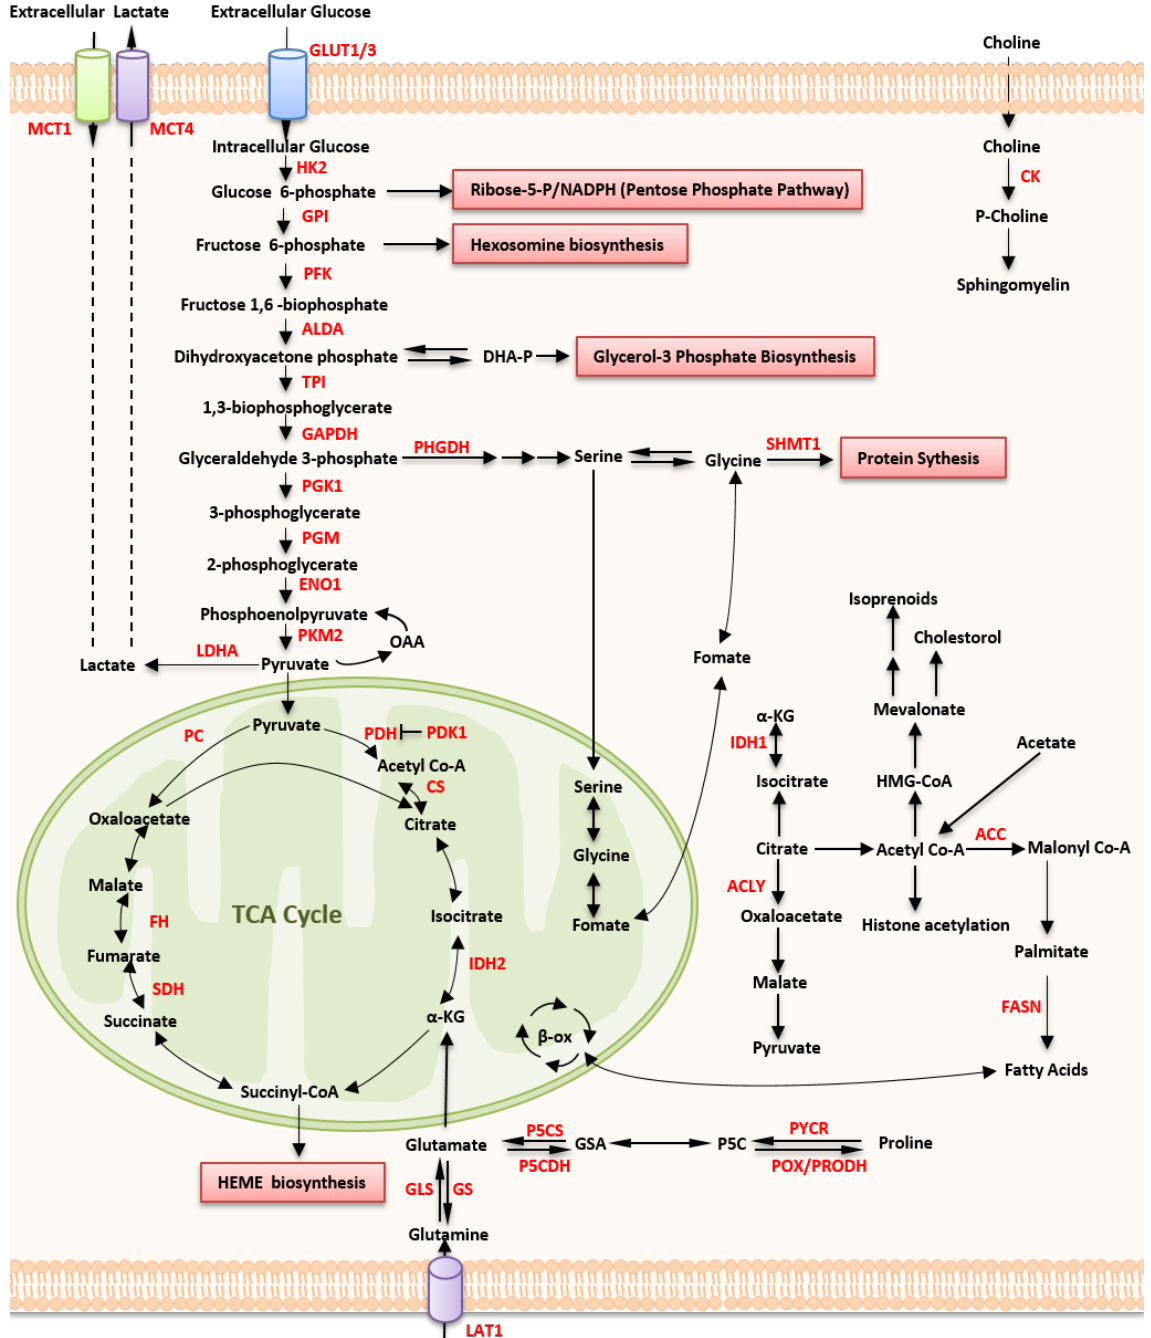
Figure 1. Metabolic pathways in lymphoma. Lymphoma cells take up glucose and glutamine also to fuel the tricarboxylic acid (TCA) cycle, oxidative phosphorylation (OXPHOS), the pentose phosphate pathway (nucleotide synthesis), and the syntheses of hexosamine (involved in the synthesis of glycosylated molecules), amino acids (proteins), and lipids. Lymphoma cells are also able to take up lactate, free fatty acids, and ketones released predominantly by surrounding catabolic cells, which can be used to replenish TCA-cycle intermediates and fuel OXPHOS. Together, these pathways generate sufficient levels of cellular components to support cell proliferation (necessary nutrient transporters and metabolic enzymes are highlighted in red). Abbreviations: MCT1, monocarboxylate transporter 1; MCT4, monocarboxylate transporter 4; GLUT1/GLUT4, glucose transporter 1/4; HK2, hexokinase; GPI, glucose-6-phosphate isomerase; PFK, phosphofructokinase; ALDA, al- dolase A; TPI, triosephosphate isomerase; GAPDH, glyceraldehyde-3-phosphate dehydrogenase;